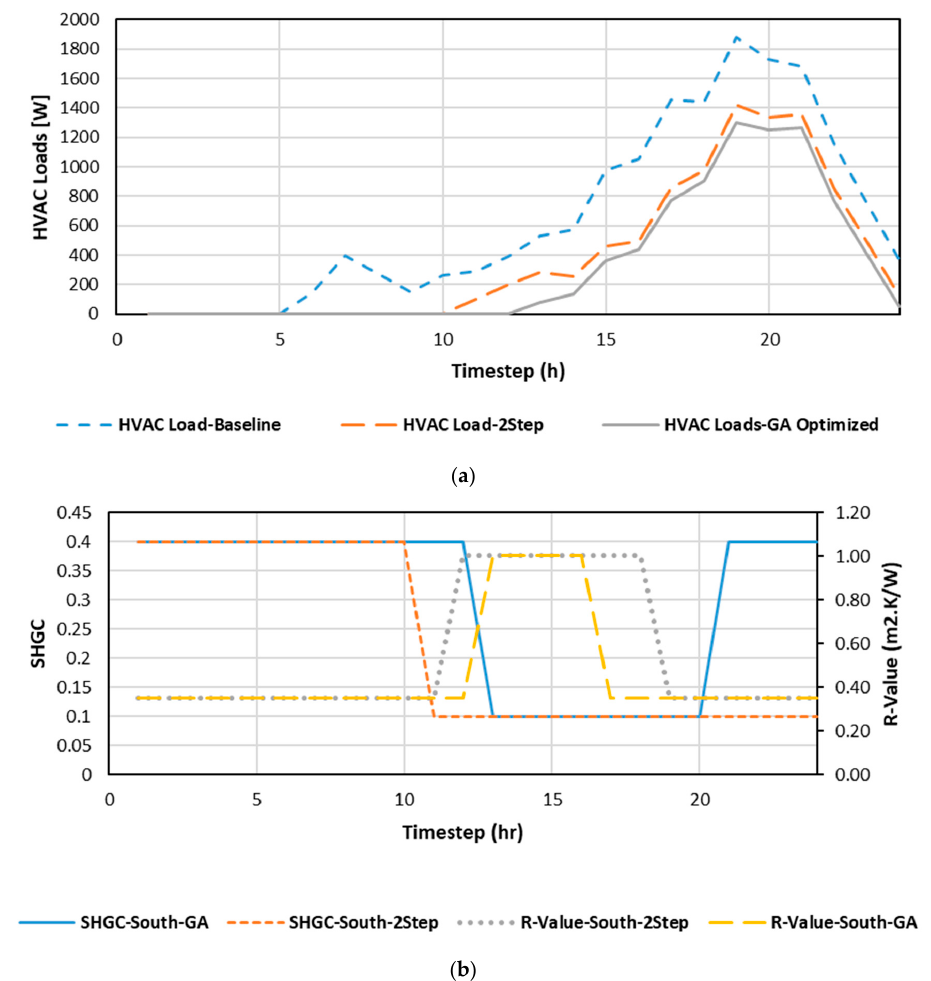
Figure 7. Hourly variations of ( a ) R-values and SHGC settings, and ( b ) thermal loads for an STIS–smart window with southern exposure during a spring day (21 May) for a dwelling located in Golden, CO,